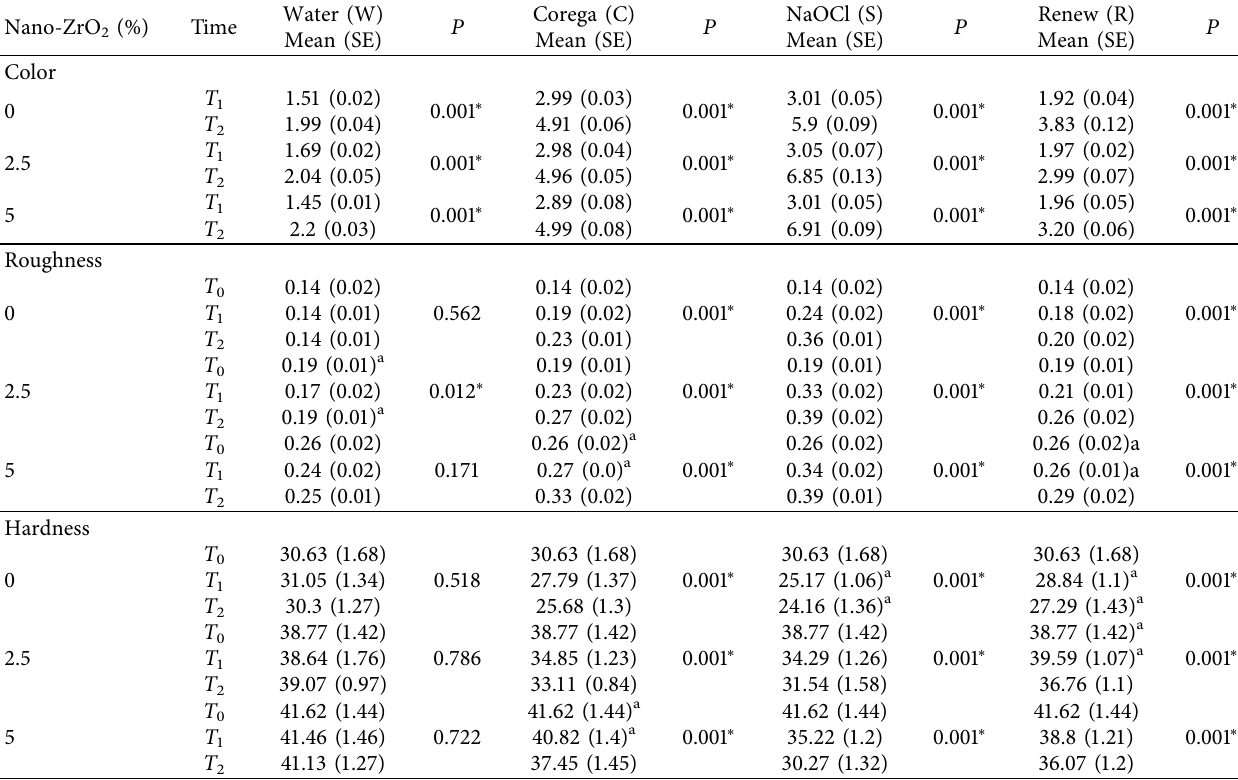
Table 3: Effect of variation in immersion time on acrylic specimen’s color ( Δ E ), surface roughness ( μ m), and hardness (VHN) after immersion in different cleansing